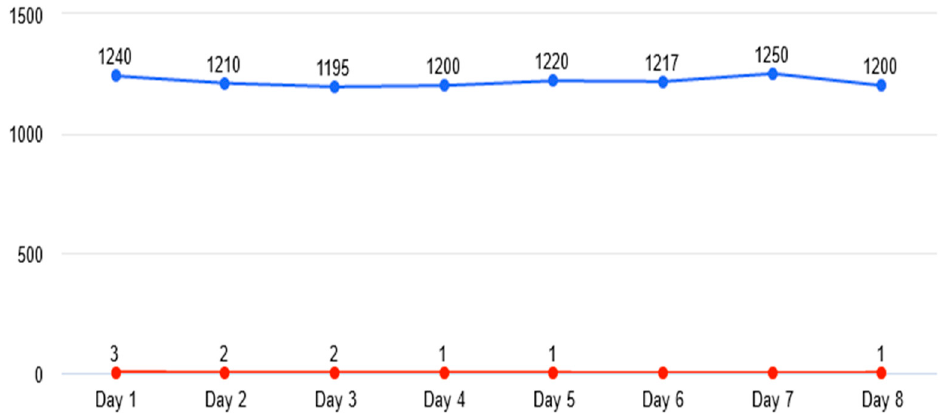
Figure 11. False detection evolution after final training.